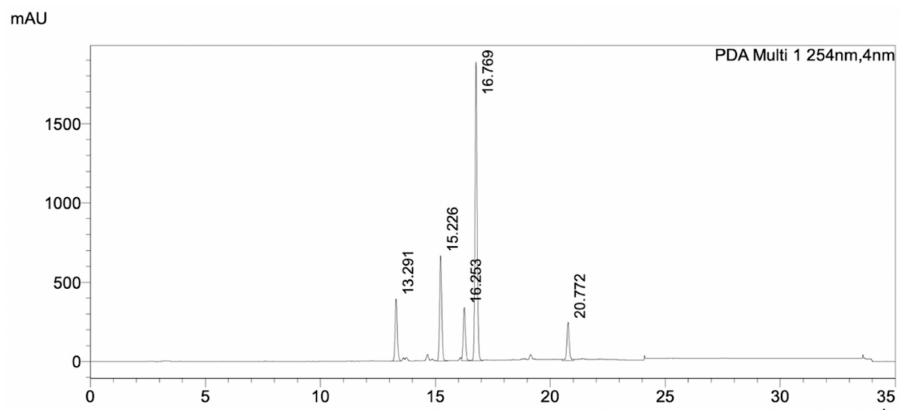
Figure 6. HPLC chromatogram of FrA from silica gel chromatography, separated by a C 18 column. The data was taken by PDA detector. Detail of the HPLC condition is described in Section 4. The chromatogram showed the UV absorbance profile of the sample at wavelength of 254 nm.